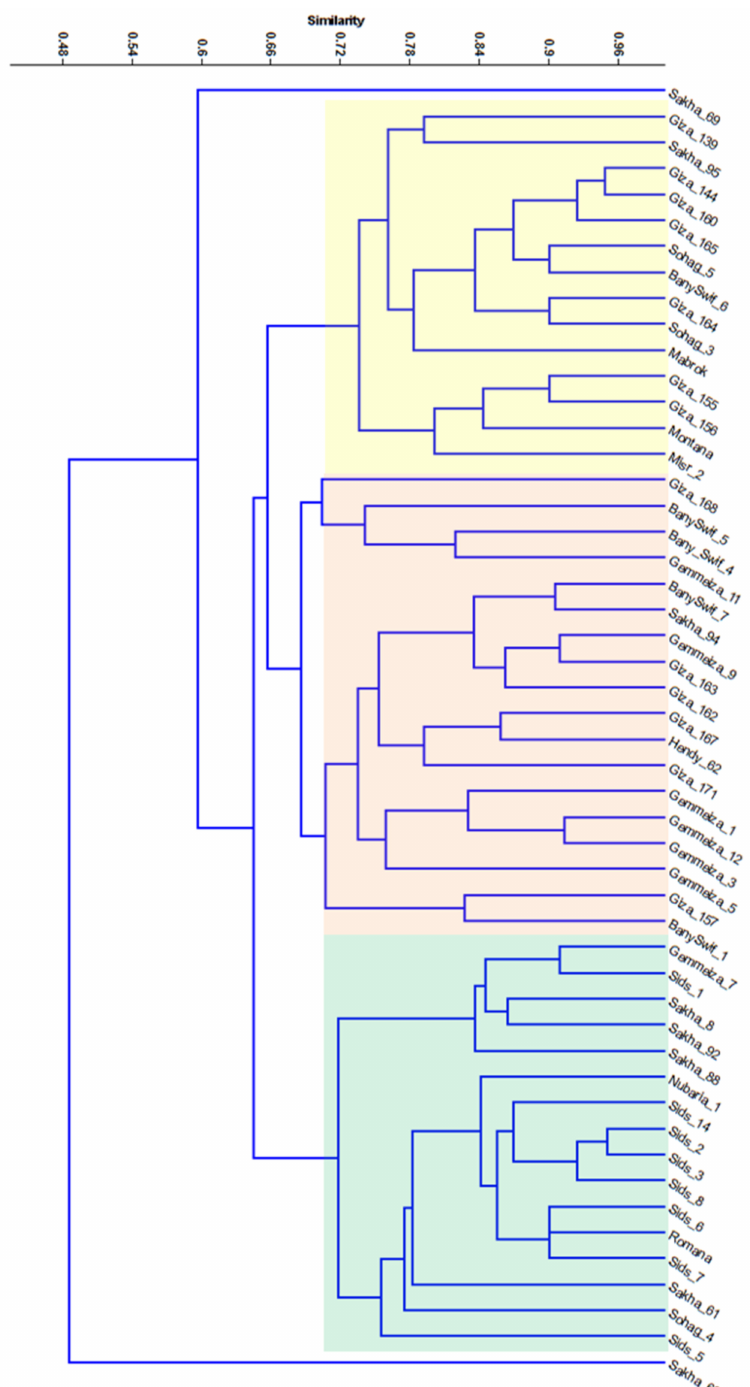
Figure 3. Phylogenetic tree showing the similarity among 50 wheat varieties based on Jaccard’s similarity analysis of 28 Lr genes